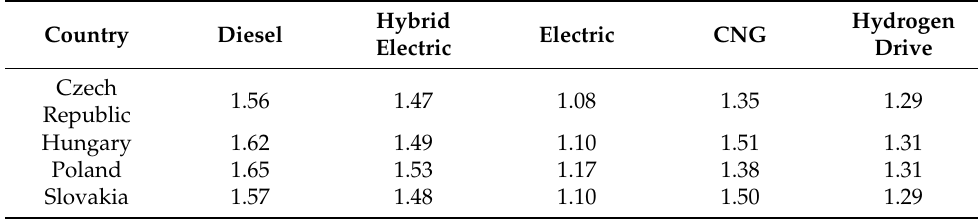
Table 12. Cost of a vehicle-kilometer of maxi buses (12 m) with various propulsion in the V4 countries for the entire period of vehicle operation (in the case of obtaining financing for the purchase of the vehicle in € ). Country